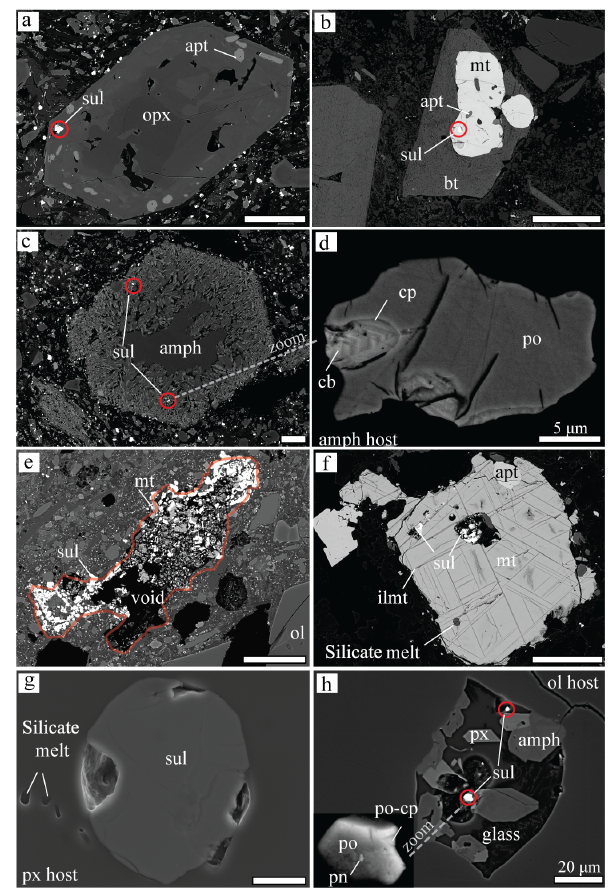
Figure 5. Backscattered electron (BSE) (a–f, h) and secondary elec- tron (SE) (g) microphotographs of sulfides, their host, and accessory mineral phases. Important things to note: (a) the common occur- rence of apatite inclusions observed together with the sulfide and hosted by the same mineral (px in a and mt in b, f ); (b) the lack of sulfides in the biotite phenocrysts, even in the cases in which the bi- otite itself includes a magnetite that hosts sulfides; (c) the usual sul- fide presence in the amphibole destabilised rim, where amphibole is being replaced by clinopyroxene, plagioclase, and rhönite, charac- terising the Kula volcano (also seen by Grutzner et al., 2013); (d) re- sorbed sulfide found in amphibole in (c) showing a rapid unmixing of the cp–cb (iss); (e) unusually big (up to 600µm) sulfide aggregate composed of mostly Cu-poor sulfides, magnetite, and micro-sized silicates found in Kula; (f) partly dissolved sulfide hosted by mag- netite that shows ilmenite exsolution lamellae; (g) a trail of bub- bles of the silicate melt and vesicles associated with the sulfide; and (h) daughter sulfide ( < 0 . 5µm) composed mostly of po found in recrystallised melt inclusion hosted by olivine, as observed in Kula. For abbreviations, see the legend in Fig. 4. The scale bar cor- responds to 100µm unless stated otherwise.